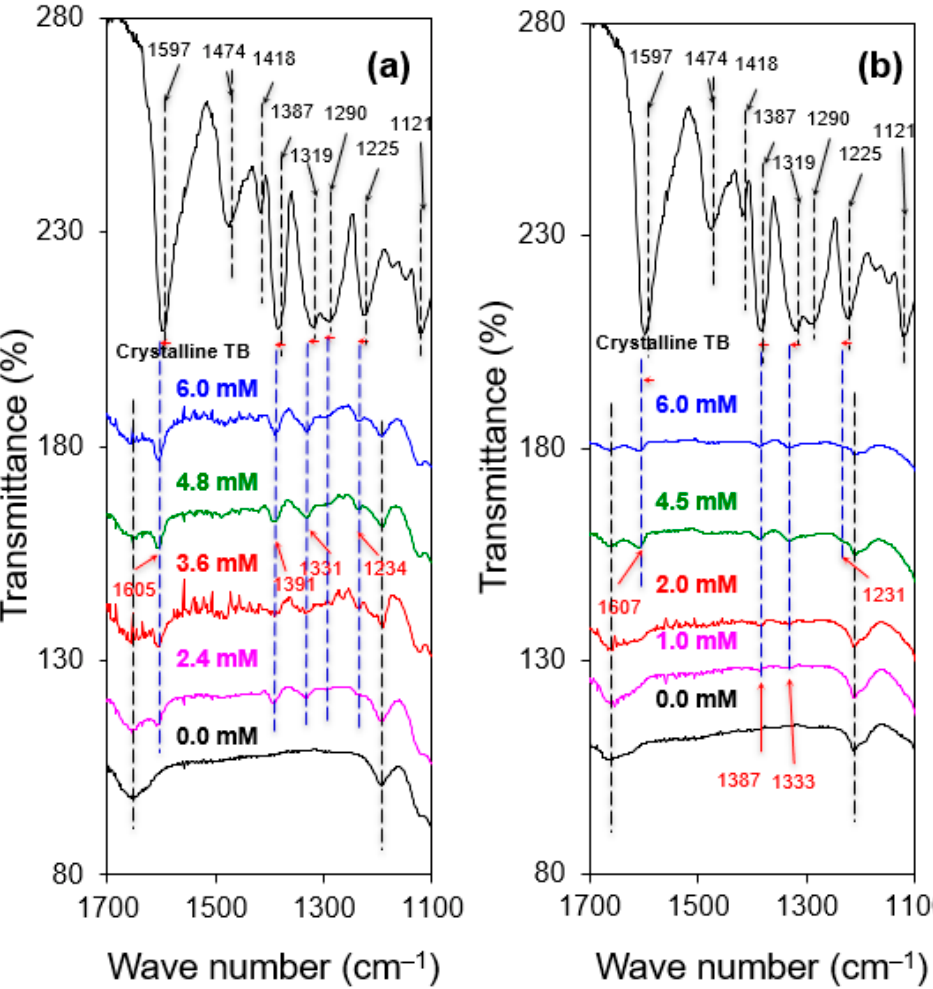
Figure 7. Enlargement of FTIR spectra in the wave numbers of 1100–1700 cm –1 after TB sorption from different initial concentrations on PAL ( a ) and SEP ( b ).